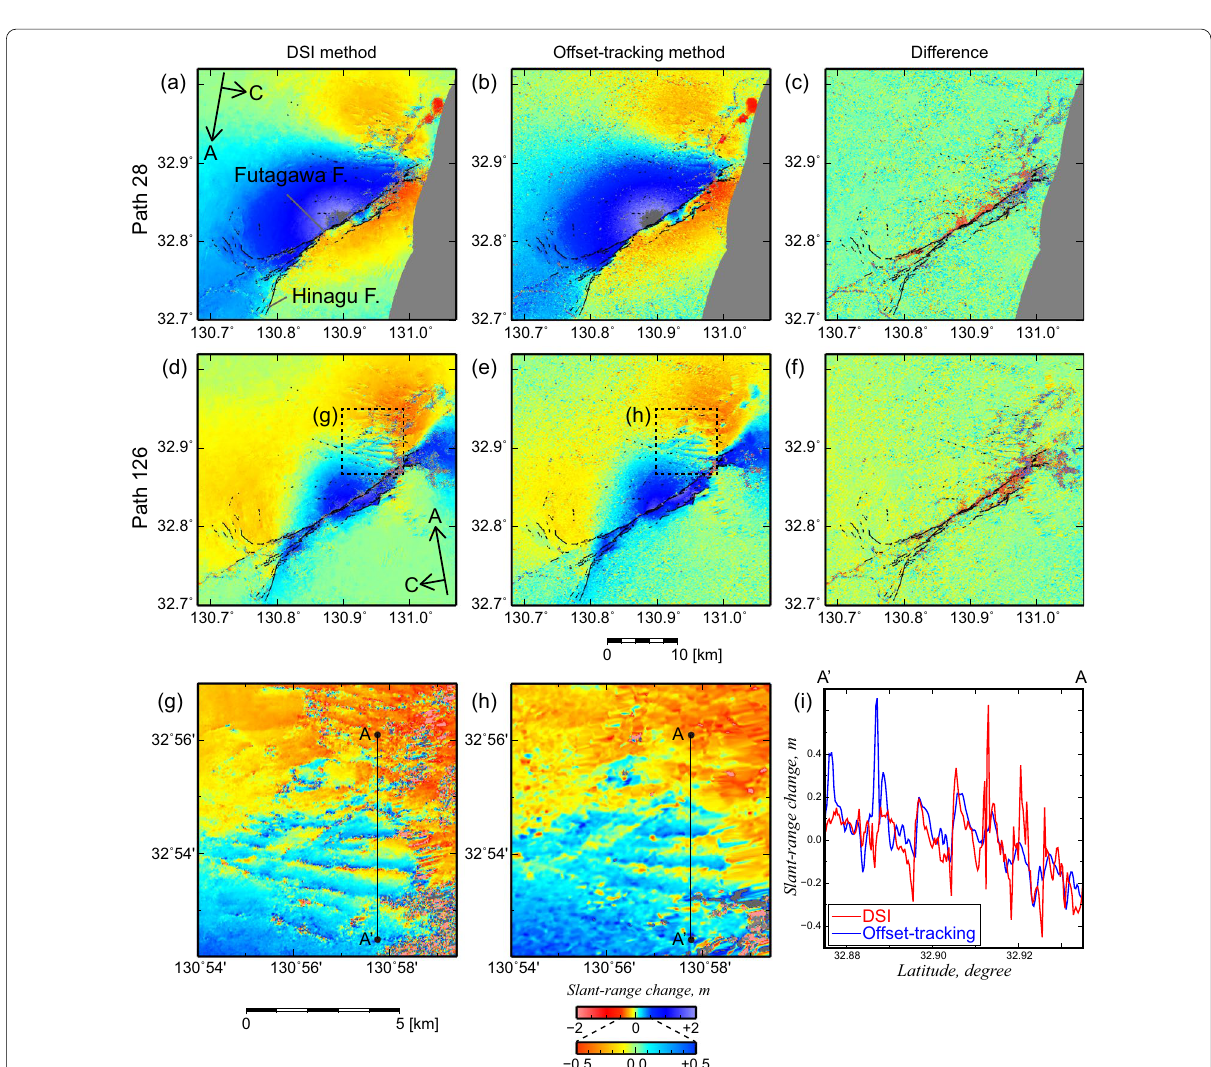
Fig. 2 Slant-range change maps obtained using the difference of split-band interferograms (DSI) and offset-tracking analyses. Arrows in the figures indicate the along-track (A) and cross-track (C) directions. Thin lines depict the surface ruptures associated with the 2016 Kumamoto Earthquake (Awata et al. 2019; National Institute of Advanced Industrial Science and Technology 2019). a, b Slant-range change maps for Path 28 using the DSI and offset-tracking analyses, respectively, and ( c ) the difference between them. d, e Slant-range change maps for Path 126 using the DSI and offset-tracking analyses, respectively, and ( f ) the difference between them. g , h Enlarged slant-range change maps from the DSI and offset-tracking analyses for Path 126. The area corresponds to the dashed areas in ( d and e ). i Comparison of slant-range changes from the DSI and offset-tracking analyses along profile A–A’ shown in ( g and h